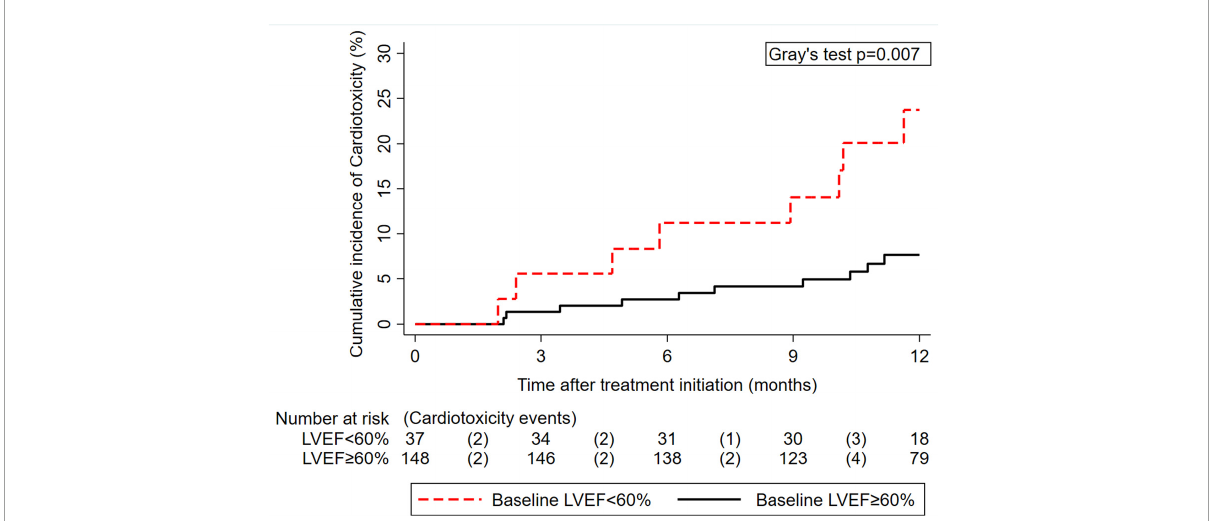
FIGURE1 Cumulative 12-month incidence of cardiotoxicity according to pre-treatment left ventricular ejection fraction (LVEF) ( n = 185). The numbers below the x-axis represent a risk table, with the number of patients at risk for cardiotoxicity at the beginning of each interval and the number of patients who developed cardiotoxicity during the pertinent interval in round